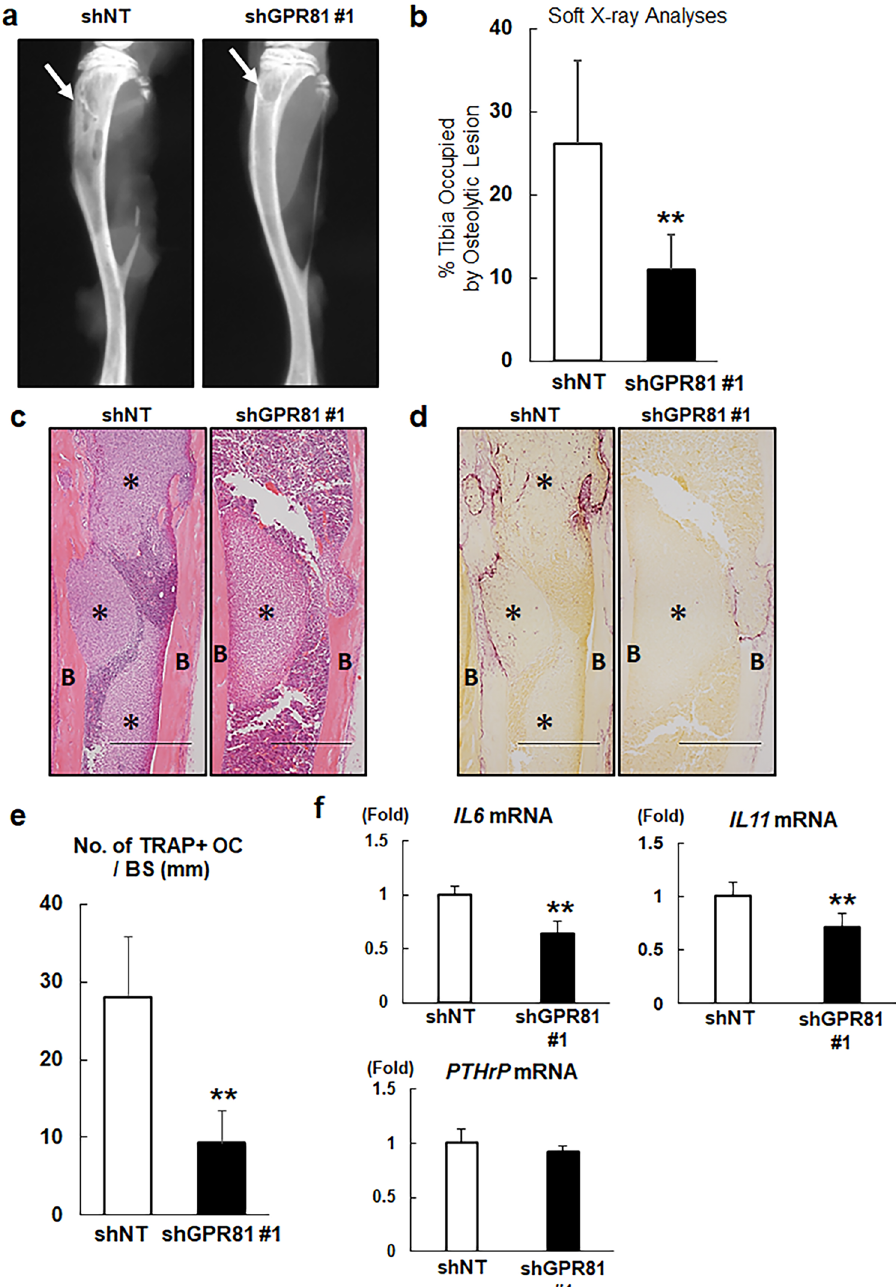
Figure 5. Impaired osteolytic tumor growth of shGPR81-transduced MDA-MB-231 cells. ( a ) Soft X-ray analysis of the hind limbs of mice after bone marrow injections with 1 × 10 5 shNT or shGPR81 #1 cells. The arrowheads indicate the osteolytic lesions. ( b ) Osteolytic destruction was quantified by measuring the areas of the osteolytic lesions in digital X-ray images. The data are presented as the percentage of the tibia occupied by osteolytic lesions ( n = 9 mice/group). ** p < 0.01 (vs. shNT cells); Student’s t- test. ( c ) Hematoxylin and eosin staining of histological sections of the tibiae collected from the mice shown in panel ( a ). B: cortical bone, *: tumor. Scale bars 500 μm ( d ) Tartrate-resistant acid phosphatase (TRAP) staining of serial sections presented in panel (c). Note that TRAP-positive osteoclasts aligned at the endosteal surfaces. B: cortical bone, *: tumor. Scale bars 500 μm ( e ) The number of TRAP-positive osteoclasts per bone surface (no. of TRAP + OC/BS) was measured using a light microscope (mean ± s.d., n = 5/group). **p < 0.01 (vs. shNT); Student’s t -test. ( f ) Total RNA was isolated from shNT and shGPR81 #1 cells, and IL6 , IL11 , and PTHrP mRNA expression was analyzed by RT-qPCR. Data are shown as fold changes normalized to shNT (mean ± s.d., n = 3/group). ** p < 0.01 (vs. shNT); Student’s t-